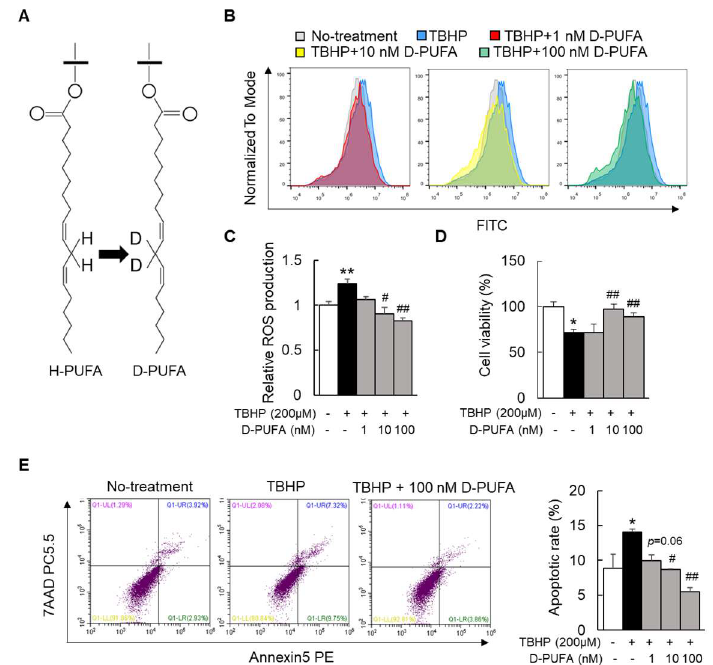
Figure 1. D-PUFAs attenuated oxidative stress and apoptosis induced by TBHP in hepatocytes. ( A ) Structural formula shift from H-PUFA to D-PUFA. ( B , C ) Relative ROS production in TBHP-treated HepG2 cells. ( D , E ) Cell viability and apoptotic rate in TBHP-treated HepG2 cells. Data are presented as means ± SEM, n = 5–6. * p < 0.05, ** p < 0.01 vs. no treatment cells; # p < 0.05, ## p < 0.01 vs. TBHP-treated cells. Significance was determined by one-way ANOVA. D-PUFA: deuterium-reinforced polyunsaturated fatty acids; H-PUFA: hydrogenated polyunsaturated fatty acids; TBHP: tert-butyl hydroperoxide; ROS: reactive oxygen